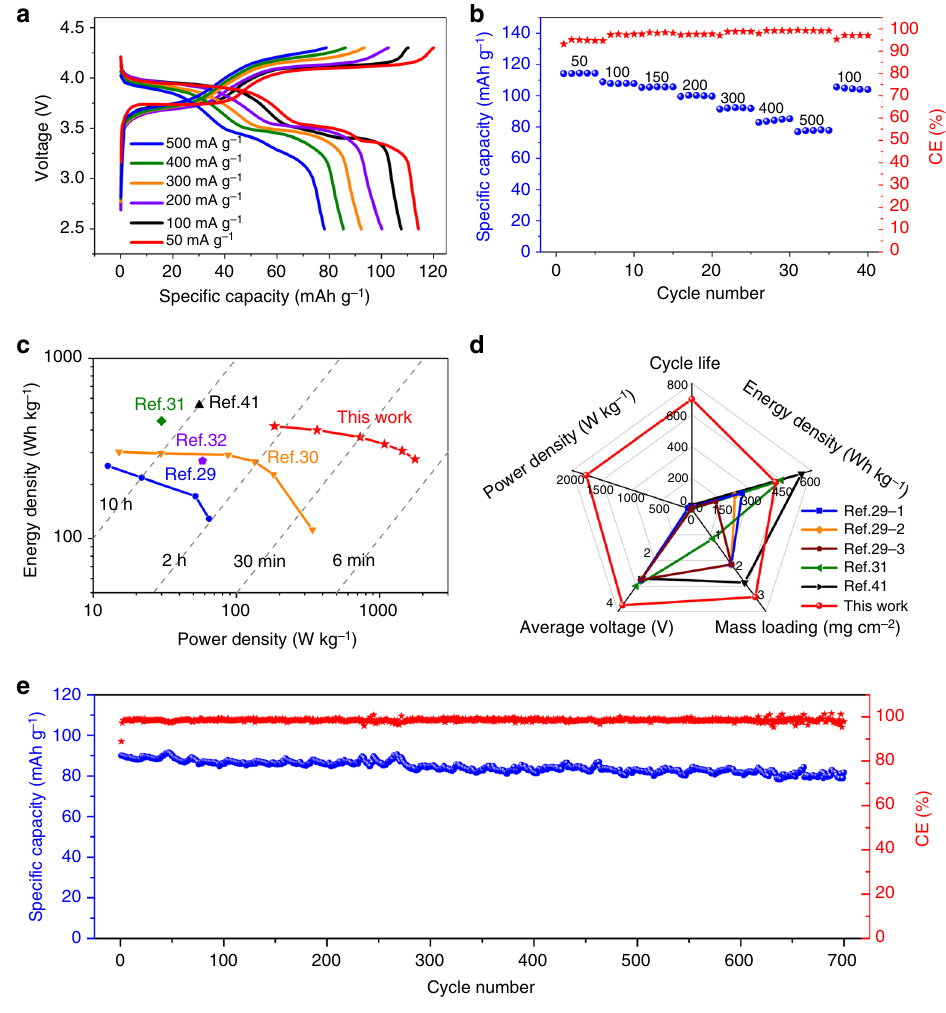
Fig. 4 Na/NVPF@GO cell performances in buffered Na – Cl – IL electrolyte. a Galvanostatic charge-discharge curves of a Na/NVPF@rGO cell at varied current density from 50 to 500 mA g − 1 . b Capacity and Coulombic ef fi ciency retention of a Na/NVPF@rGO cell when cycled at different current densities from 50 to 500 mA g − 1 . c , d Ragone and Radar plots of this work compared with other reported room-temperature Na batteries based on IL electrolytes, respectively 29 – 32,41 . The speci fi c capacity, energy and power density in this work and previous literatures were all calculated based on the mass of active materials on positive electrode. The cycle life in ( d ) is determined by the cycle number when the capacity dropped below 90% of the original capacity 29 . 1, 2 and 3 represent three different IL electrolytes based on 1 M NaBF 4 , NaClO 4 and NaPF 6 salts, respectively. e Cyclic stability of a Na/NVPF@rGO